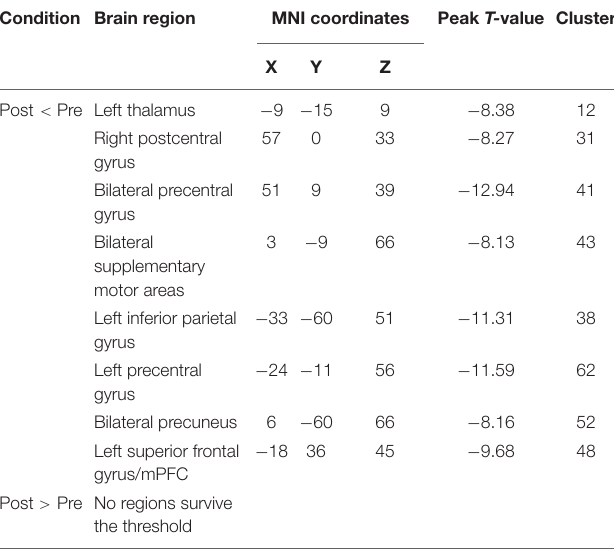
TABLE 3 | Brain regions showing differences in fALFF for patients between pre- and posttreatment. Condition Brain region MNI coordinates Peak T- value Cluster